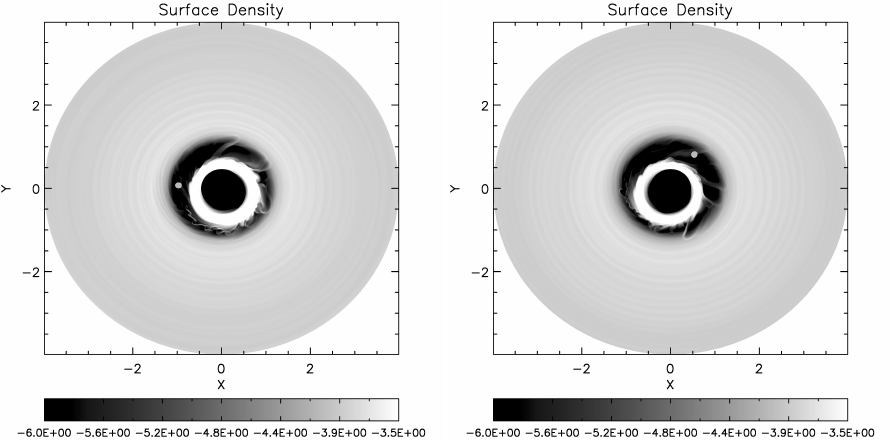
Fig. 1. log (cid:6) contours for q = 0 : 02 with a softening length of 0 : 1 H after 50 (left panel) and 100 (right panel) orbits. In these simulations the companion (the small light- gray circle), its position in each case being at the center of the white circle located within the gap region, was allowed to accrete. The width of the gaps slowly increases while the accretion rates, on average, slowly decrease with time. Short-wavelength density waves in the outer disks are just visible. Note that values of log (cid:6) below the minimum indicated on the color bar are plotted as that minimum value.